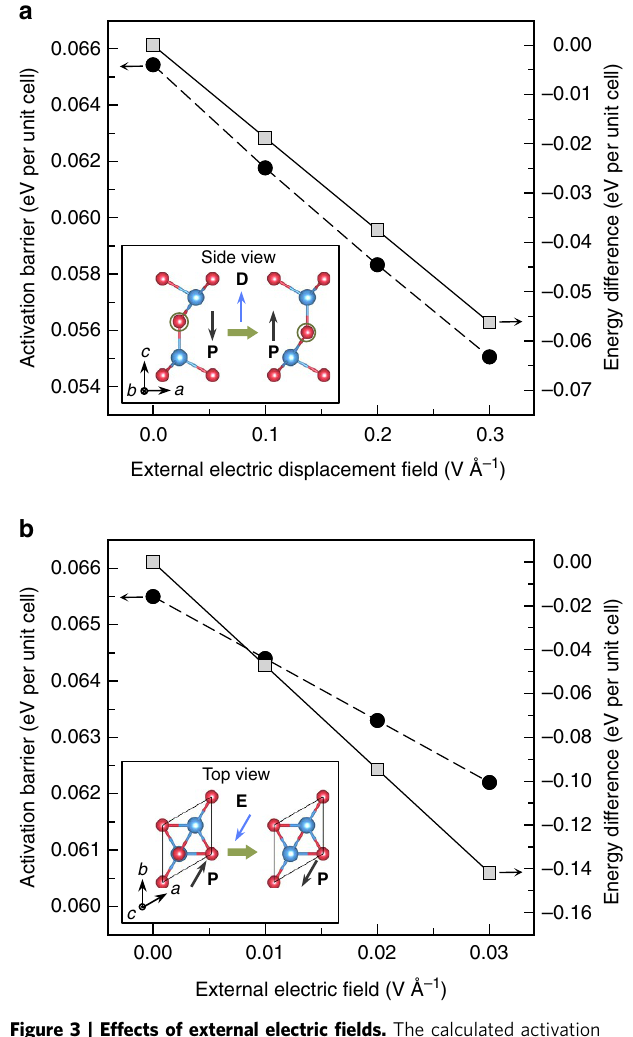
Figure 3 | Effects of external electric fields. The calculated activation barrier (black circles) and energy difference (grey squares) between the initial and final states (the insets) in the electric polarization reversal process of 1 quintuple layer In 2 Se 3 via the concerted motion as illustrated in Fig. 2b, plotted as a function of the external electric field applied in the out-of-plane direction ( a ) and in-plane [110] direction ( b ), respectively. The directions of the applied external electric fields are indicated by the blue arrows in the